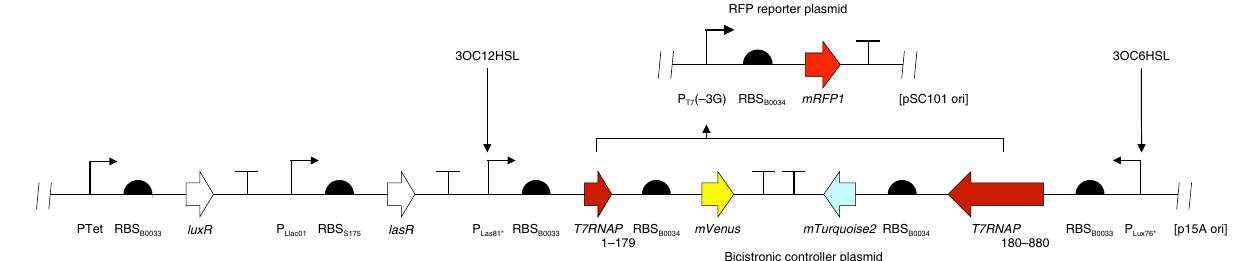
Fig. 3 Design of a split T7RNAP-based three-color circuit responsive to HSLs. Schematic representations of the mRFP1 -expressing reporter of T7RNAP activity p4g3R (see Supplementary Figure 3 for induction curve) and the bicistronic controller plasmid pCRB DRT7VTPLux*500 encoding two bicistronic operons responding to 3OC6HSL and 3OC12HSL by induction of T7RNAP[180-880] and mTurquoise2 , or T7RNAP [1 – 179] and mVenus , respectively, are shown Table 1 Comparison of a bicistronic controller plasmid and its constitutive half circuits Max corrected fl uorescence intensity [RFU]